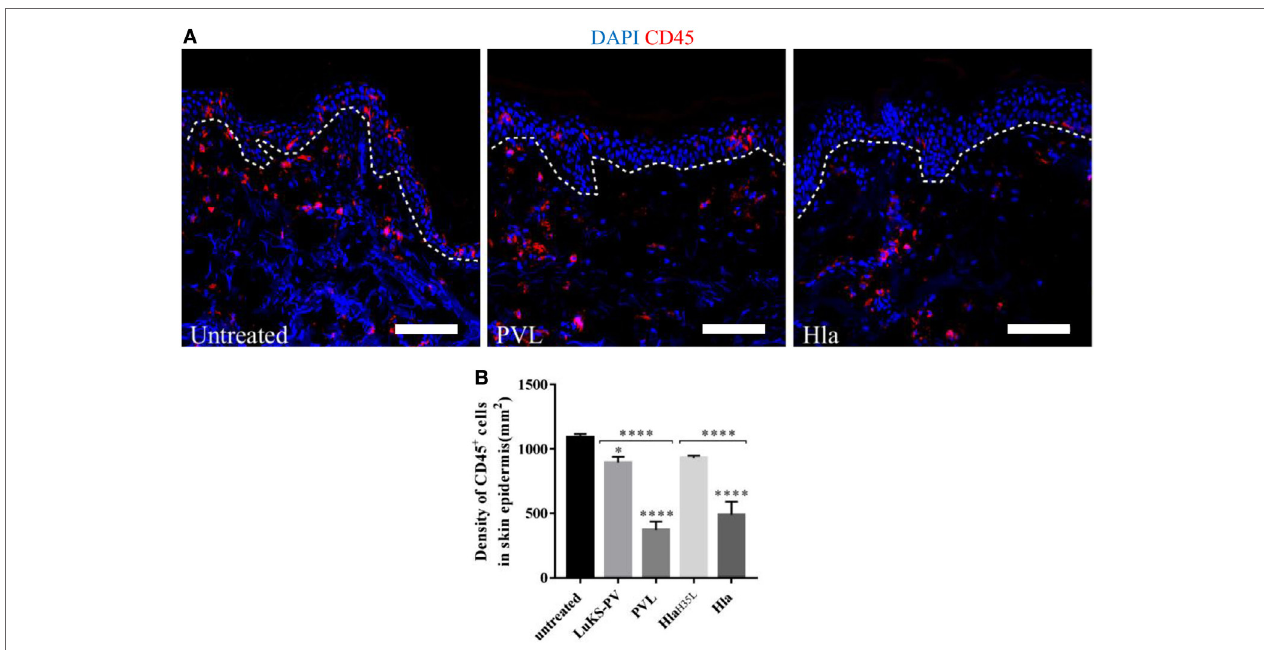
FigUre 3 | (a) Cryosections of human skin explants showing the distribution of CD45-positive cells in the epidermis of human skin 24 h post-treatment with 5 µg Hla or Panton–Valentine leukocidin (PVL). Scale bar is 100 μ m. The white dotted line represents the border between the epidermis and dermis. (B) The density of CD45 cells was calculated by counting CD45-positive cells in three to four random fields of skin sections. The density of cells measured as cell-density per square micrometers but expressed in cell-density per square millimeters. Statistically significant differences were determined by one-way ANOVA, with Tukey’s multiple comparison tests, * p < 0.05 and **** p ≤ 0.0001. Asterisks on bars are comparisons between untreated and treated groups while lines above bars are comparisons between the treated